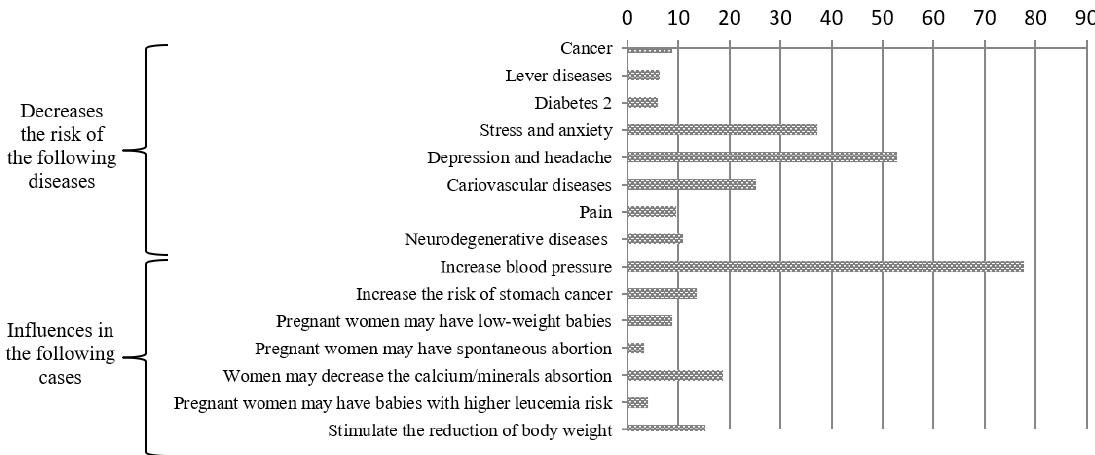
Figure 1. Consumers’ perception of health effect of coffee consumption (%). Note: Consumers’ response options were “yes”/”no” for each item. Therefore, the figure shows that around 80% of respondents thought that drinking coffee increased blood pressure.